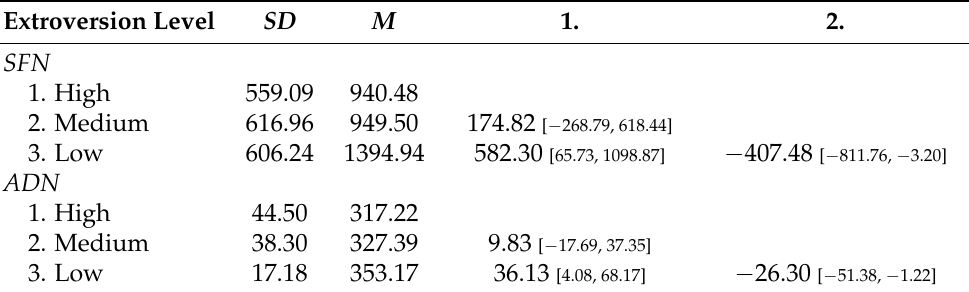
Table A19. Tukey Post Hoc Results of SFN and ADN statistic (SpaceShooter 2) by NEO-FFI Extrover- sion trait (see Table 2 for MANOVA results).